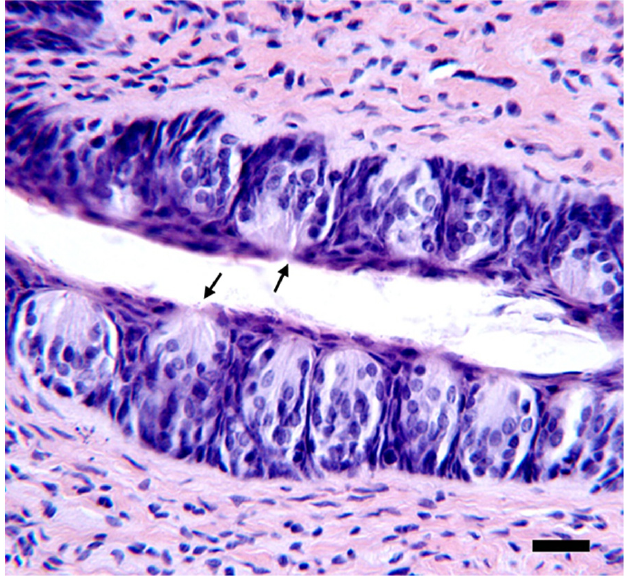
Figure 2. Representative image of CV Slice. A representative image showing the morphology of a pore (black arrows). Photomicrograph adjusted for brightness and contrast. Scale bar represents 25 µm.